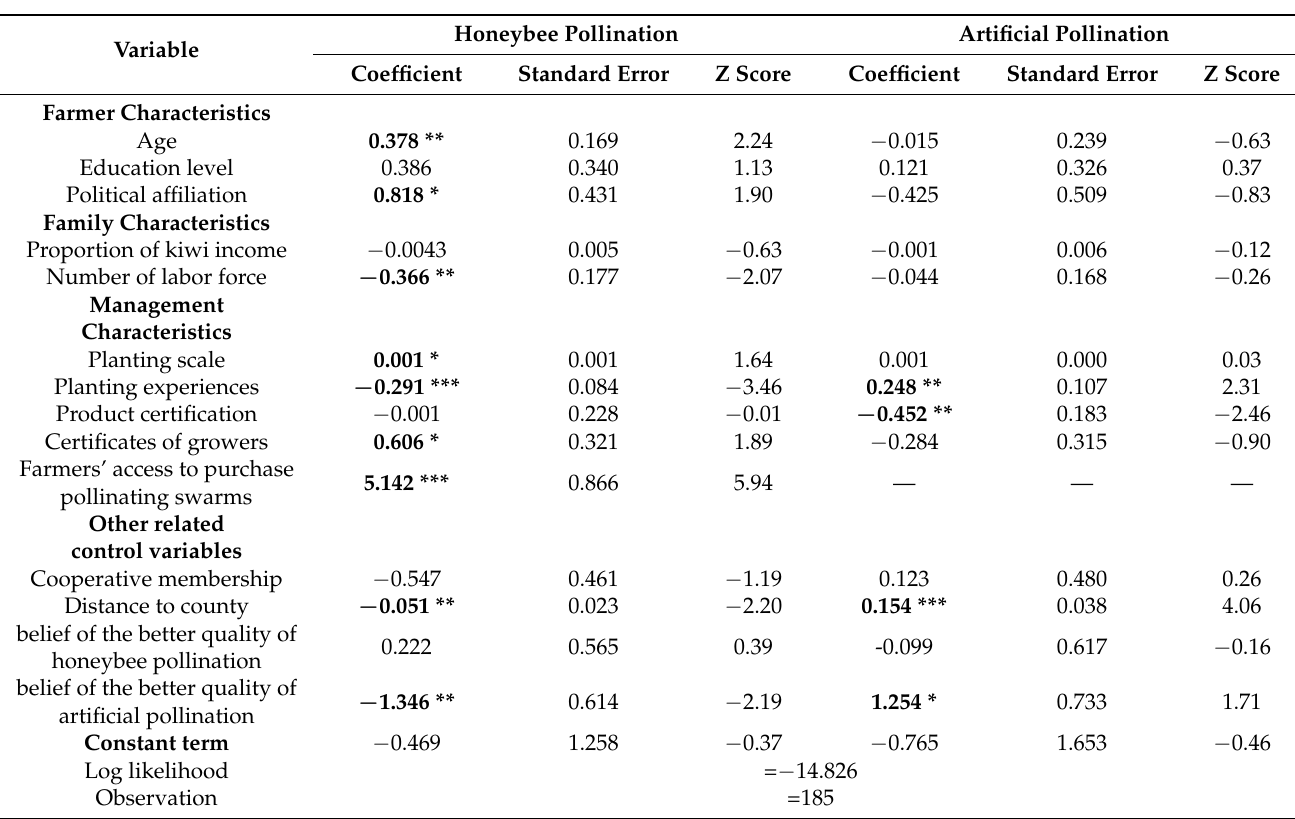
Table 3. Estimated results of the bivariate probit